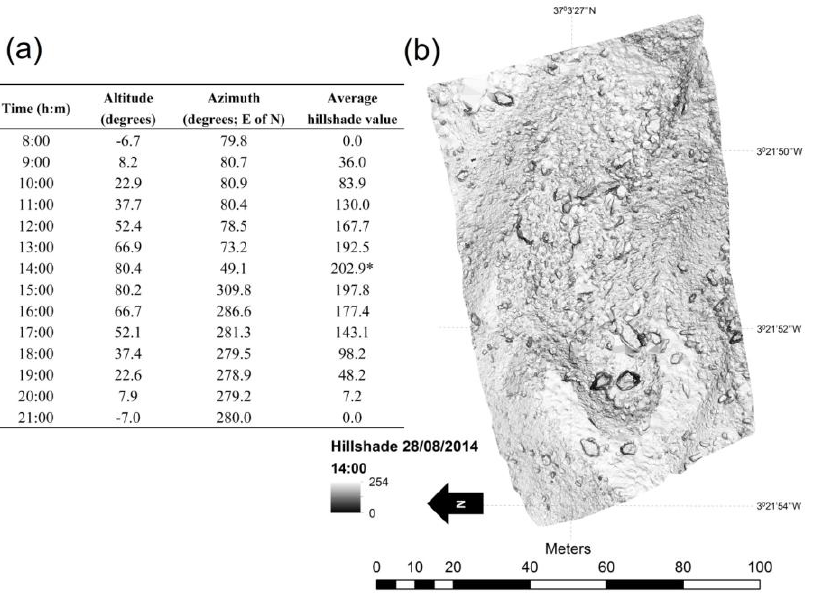
Figure 7. ( a ) Location of the sun in the sky for different times on 28 August 2014 (date planned for the next field survey) and the average hillshade value of pixels and ( b ) shaded relief model for the estimated optimal time (* 14:00 with an average hillshade value of